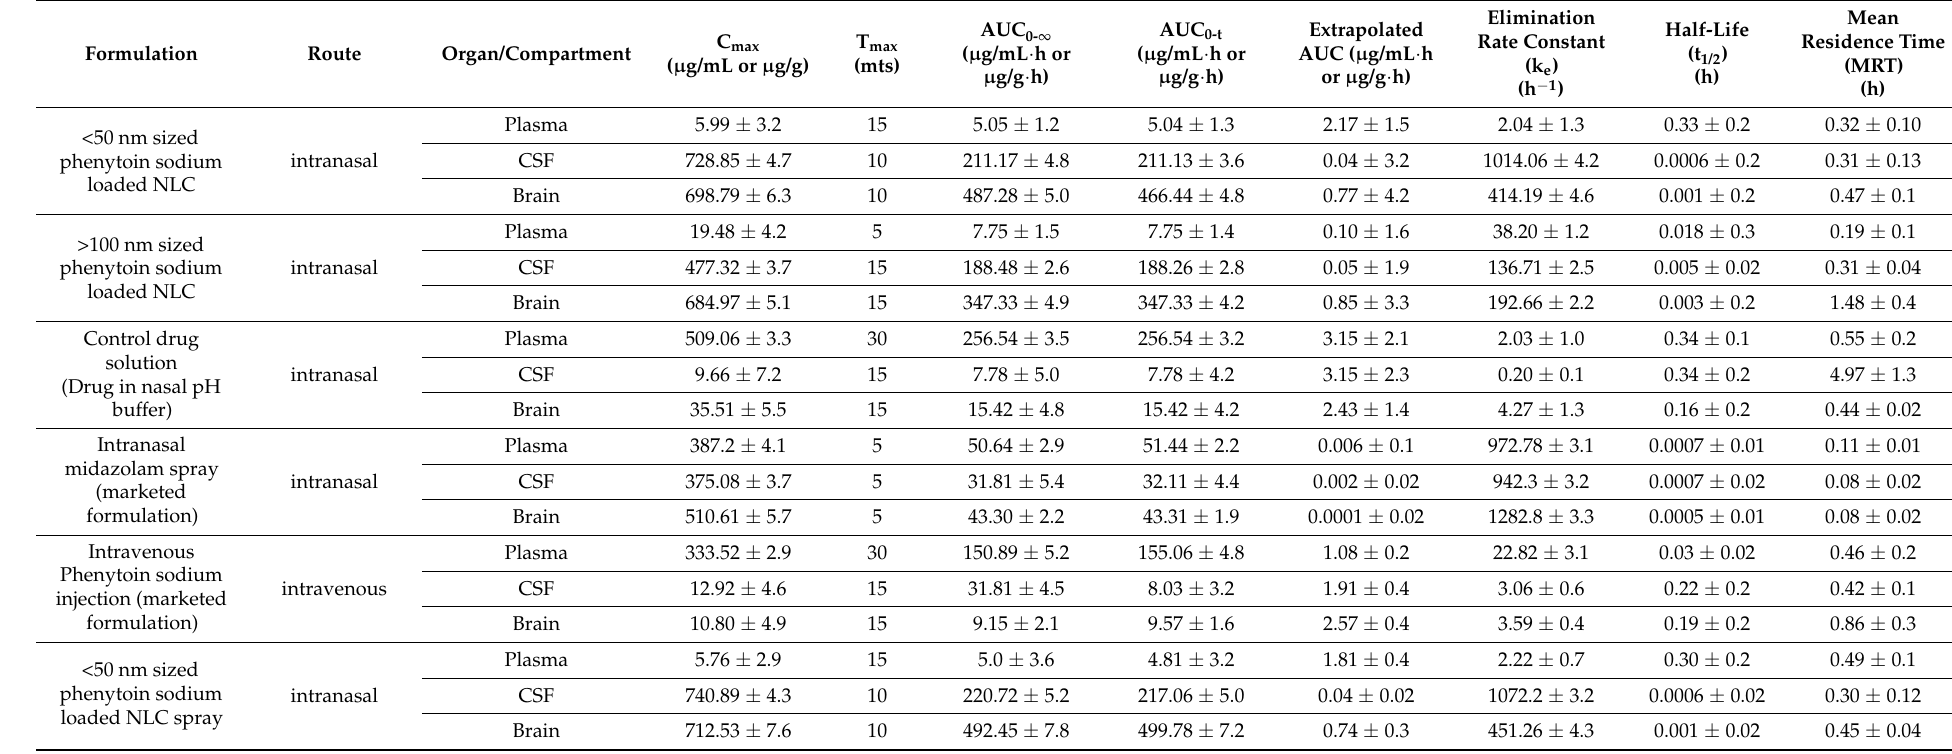
Table 2. Pharmacokinetic parameters estimated in plasma, CSF and brain using Win Nonlin ®